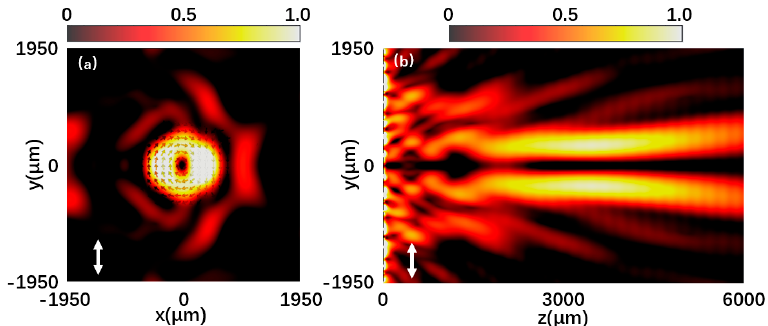
Figure 6. ( a , b ) Normalized intensity distribution at 0.7 THz under the y-polarized light incidence.